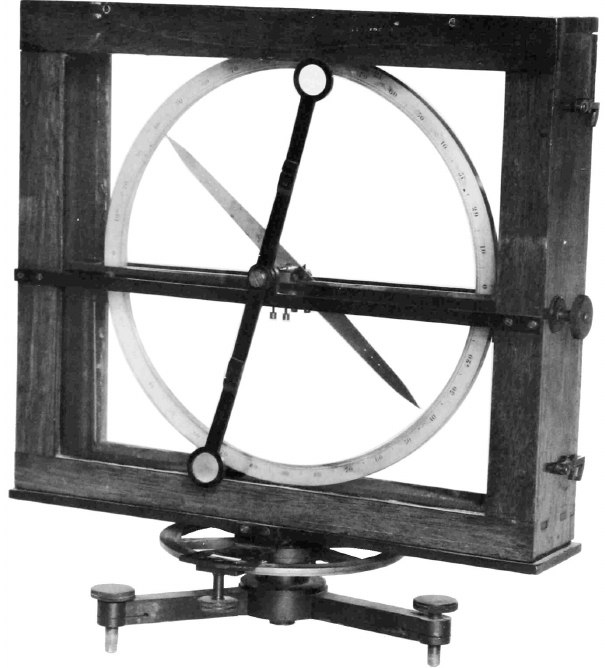
Figure 15. A similar dip circle manufactured by Barrow (Multhauf and Good, 1987) was in use at Colaba from 1846 to 1867. It was a simple apparatus without a microscope. The vertical movement of the scale was harnessed to find I